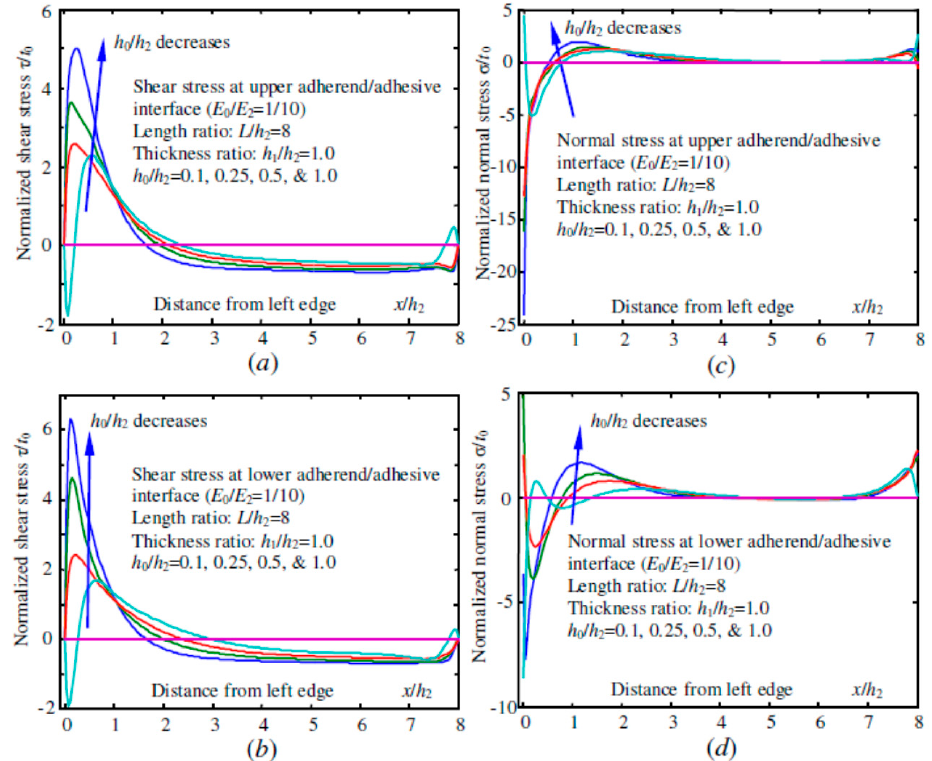
Figure 5. Comparison of the interfacial shear and normal stresses at the upper and lower adherend/adhesive interfaces of an ABSLJ subjected to a shear force ( E 0 / E 2 = 1/10, h 1 / h 2 = 1.0, and h 0 / h 2 = 0.1, 0.25, 0.5, and 1.0, respectively). ( a , b ): Shear stresses at the upper and lower adherend/adhesive layer interfaces, respectively; ( c , d ): Normal (peeling) stresses at the upper and lower adherend/adhesive layer interfaces, respectively.